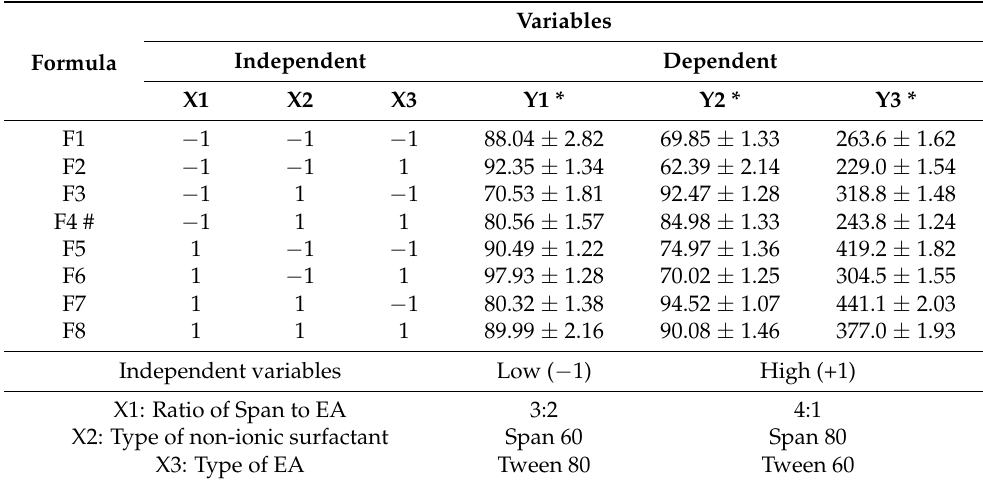
Table 1. The 2 3 factorial design and the composition of EGCG-loaded